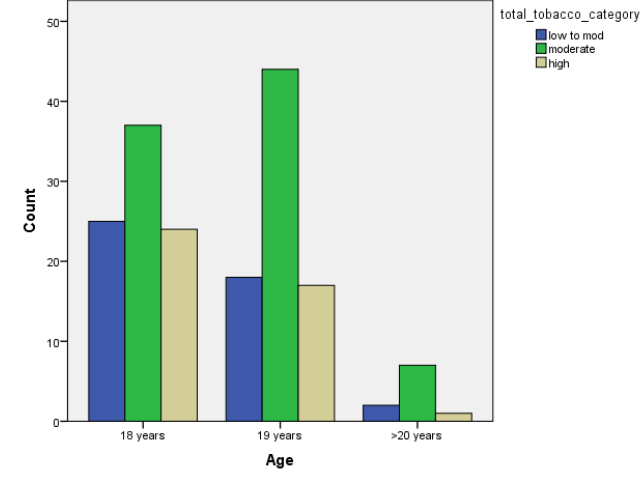
Figure 1. Frequency of tobacco and alcohol consumption depending on age (male).